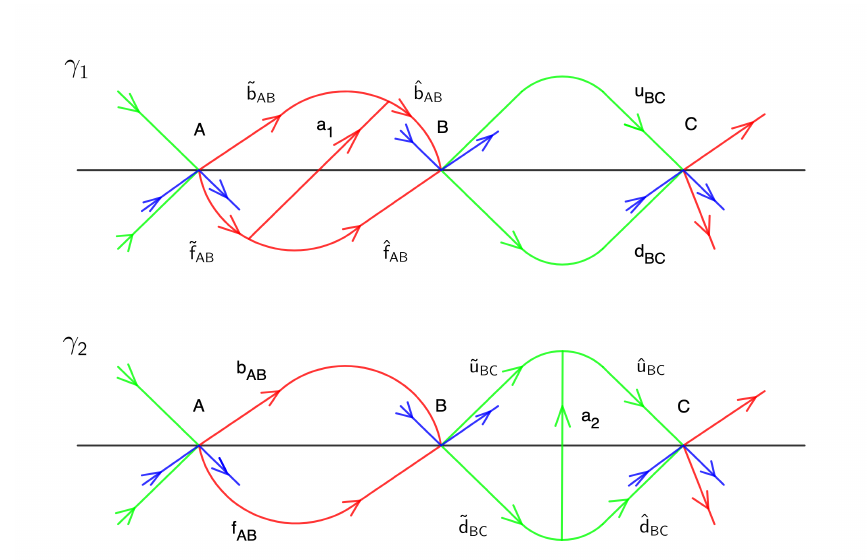
Figure 2. The figure shows the two contributing children graphs. Only the subdivided edges and arcs are highlighted; the rest of the graphs are identical to the parent